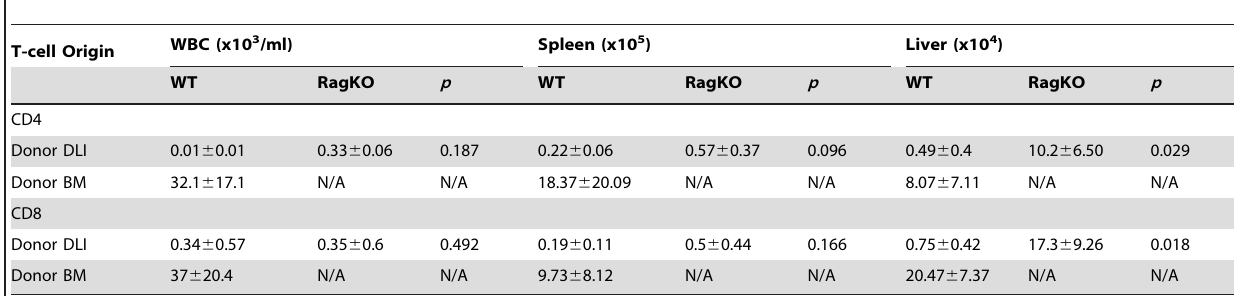
Table 2. Accumulation of donor DLI-derived T cells in parenchymal, but not lymphoid, tissues in RagKO chimeras (Mean 6 SDs).